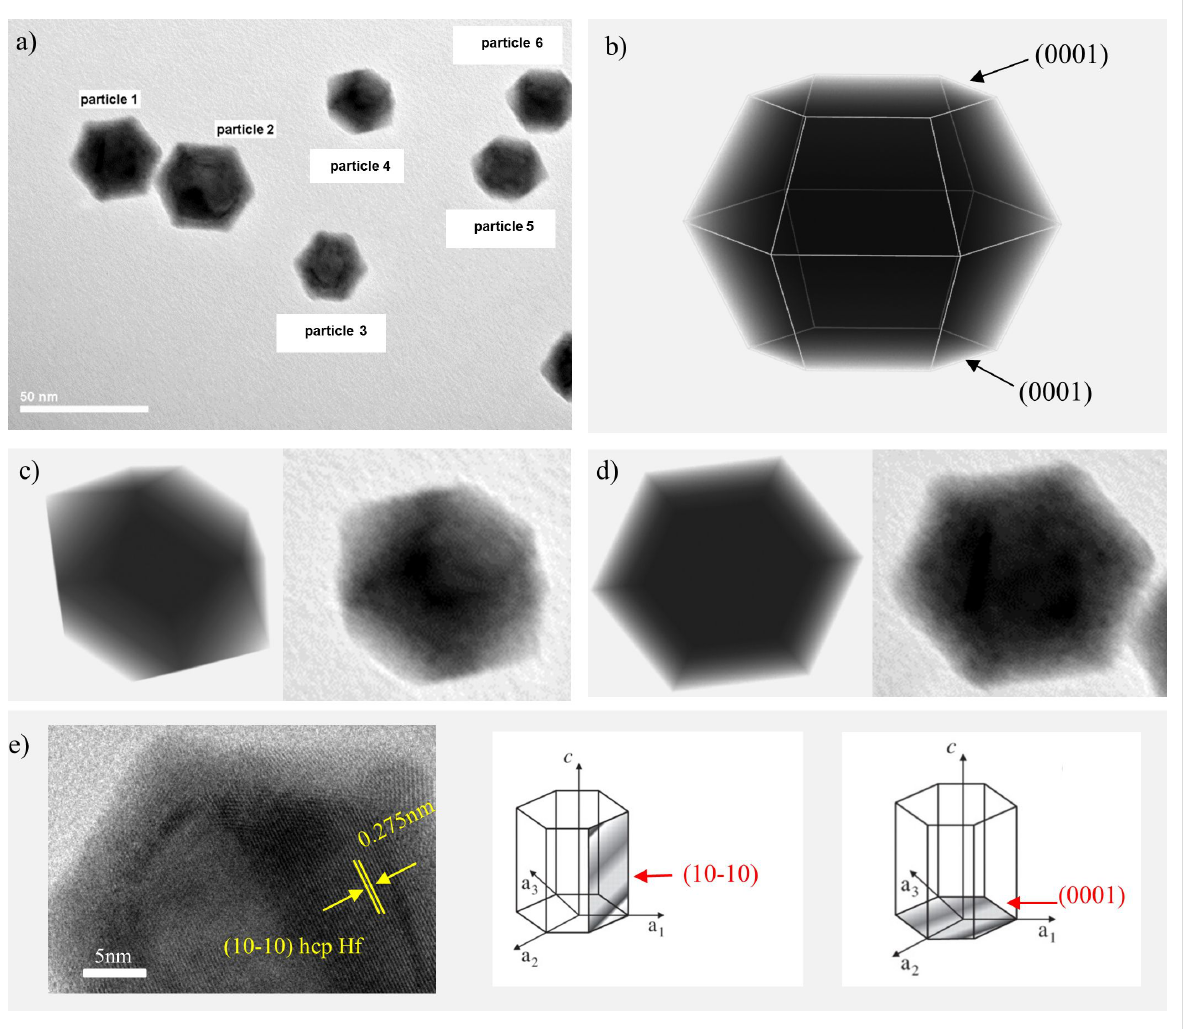
Figure 4: a) Bright-field TEM image of Hf nanoparticles; b) 3D geometric model of the truncated hexagonal biprism constructed with the technique of volume rendering; c) geometric model of the volume-rendered truncated biprism placed on one biprismatic plane (left) and the corresponding TEM of nanoparticle 4 (right); d) geometric model of the volume-rendered truncated biprism placed on the basal plane (left) and the corresponding TEM of nanoparticle 1 (right); e) HRTEM image of the basal plane of nanoparticle 1. Lattice fringe measurements correspond to (10 − 10) plane of hcp